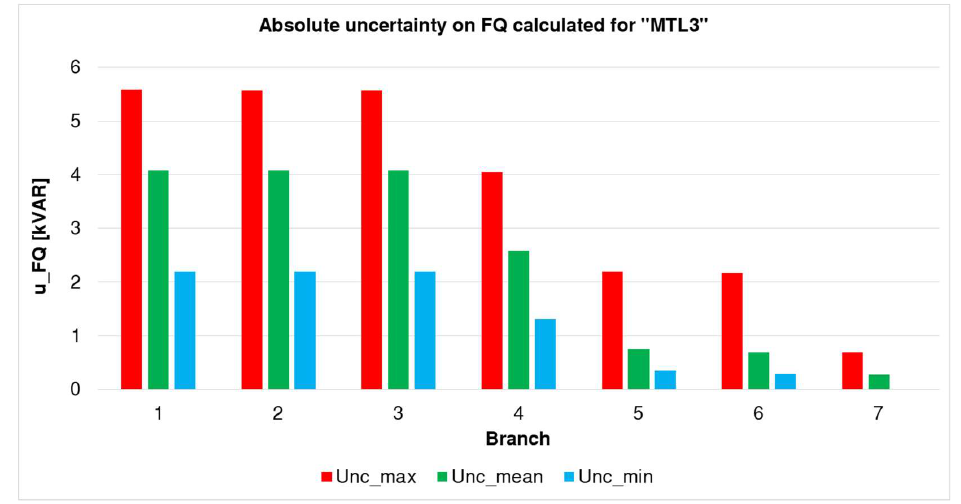
Figure 20. Maximum, average and minimum values of the absolute uncertainties in the reactive power flows calculated of the “MTL3” line (31 May 2018).